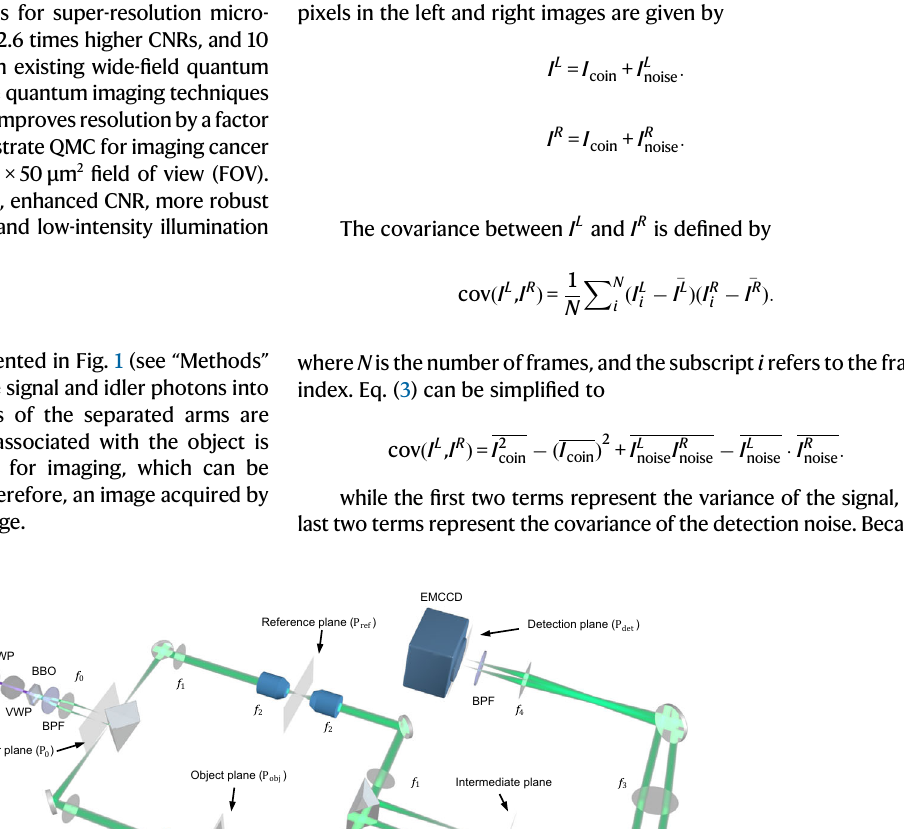
charge-coupled device camera. f 0 =50mm, f 1 =180mm, f 2 =9mm, f 3 =300mm, and f 4 =200mm.The source Fourierplane P 0 issetatthe Fourierplaneof theBBO